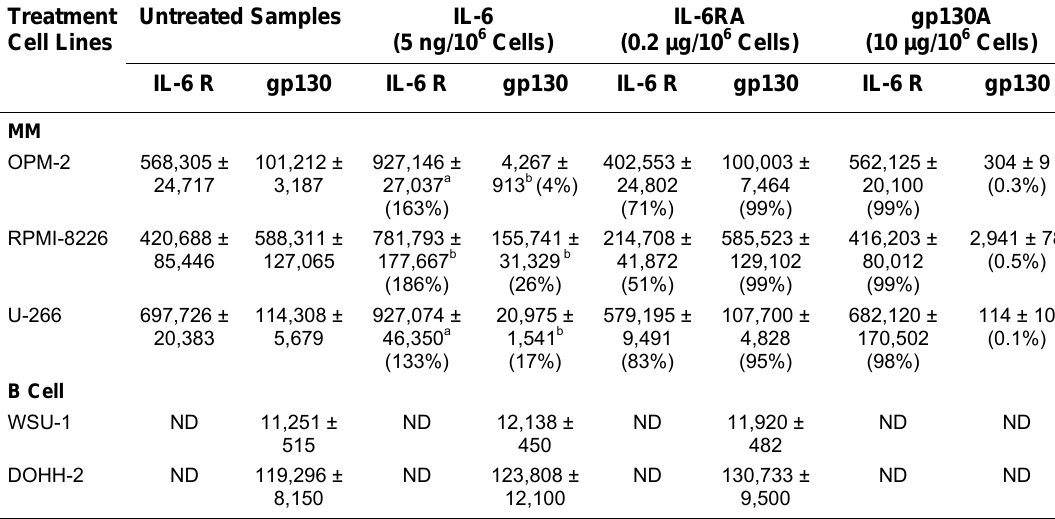
The cells were incubated for 24 h. The results of four independent experiments are presented as mean ± SEM. For the expression of the membrane IL-6R and gp130, the signal intensity was taken as parameter. The percentage of untreated samples was taken as 100%.